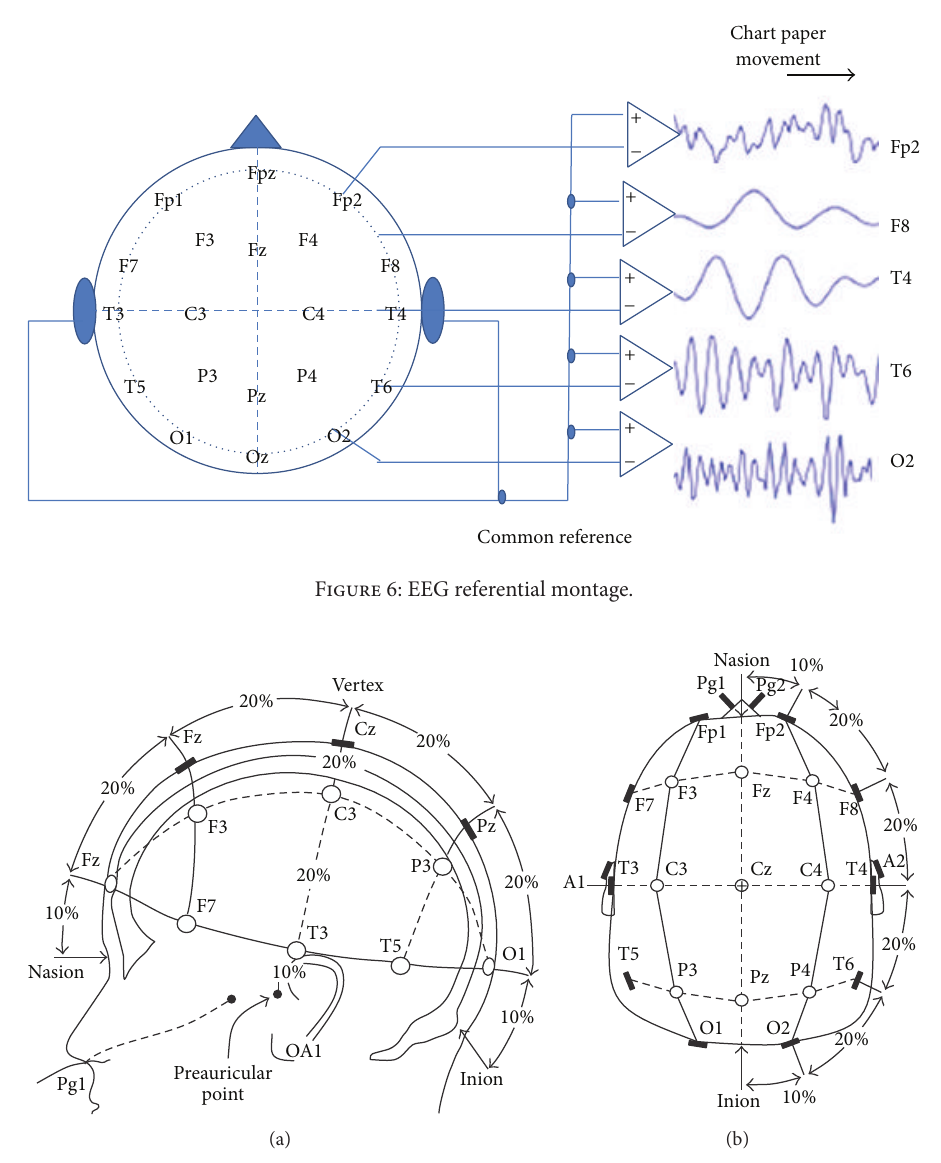
Figure 7: The 10–20 EEG electrodes placement system. (a) and (b) Three-dimensional side view and top view, respectively